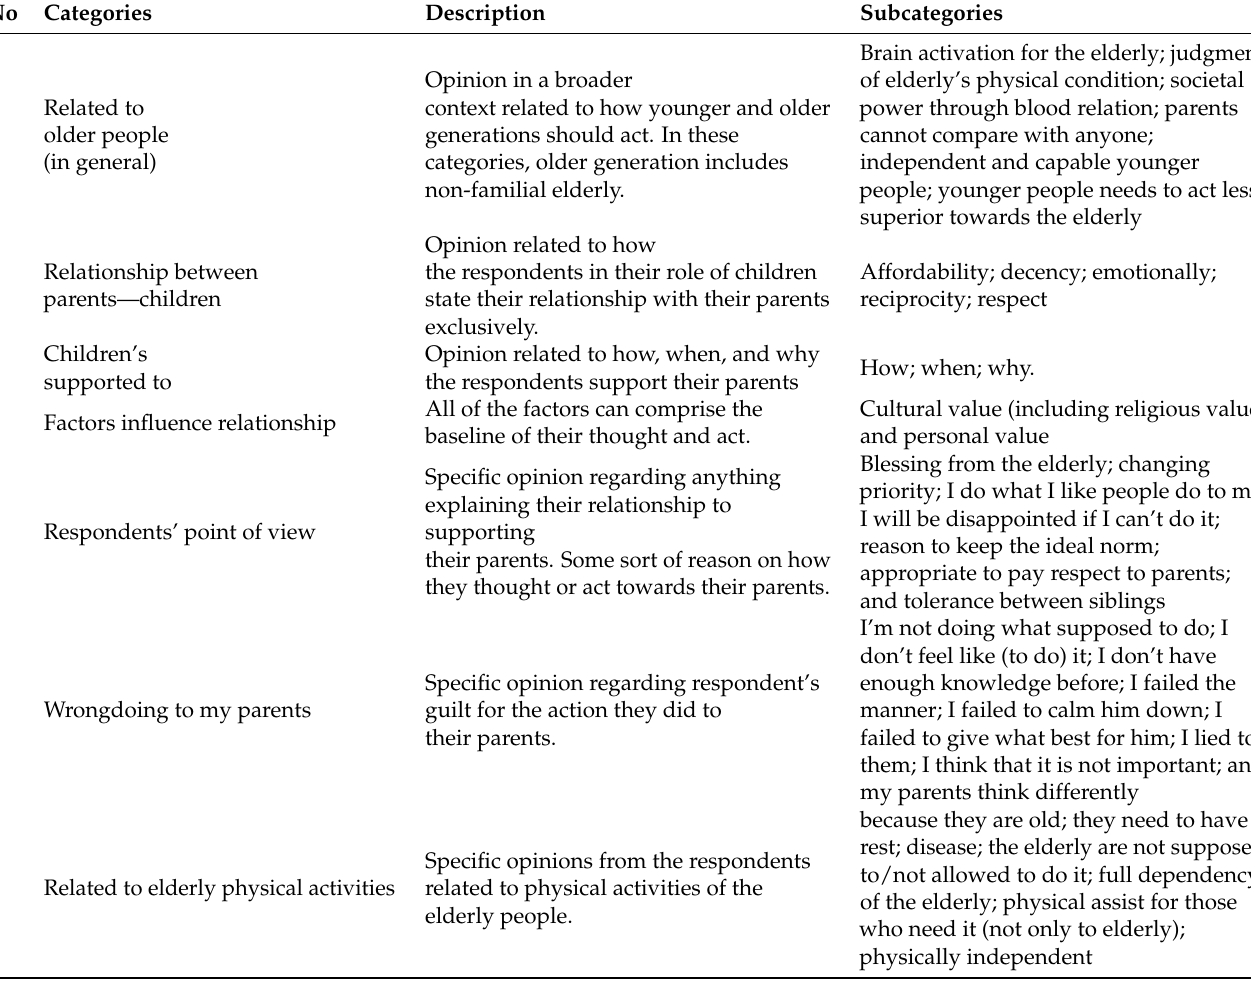
Table 2. Categories clustered based on initial